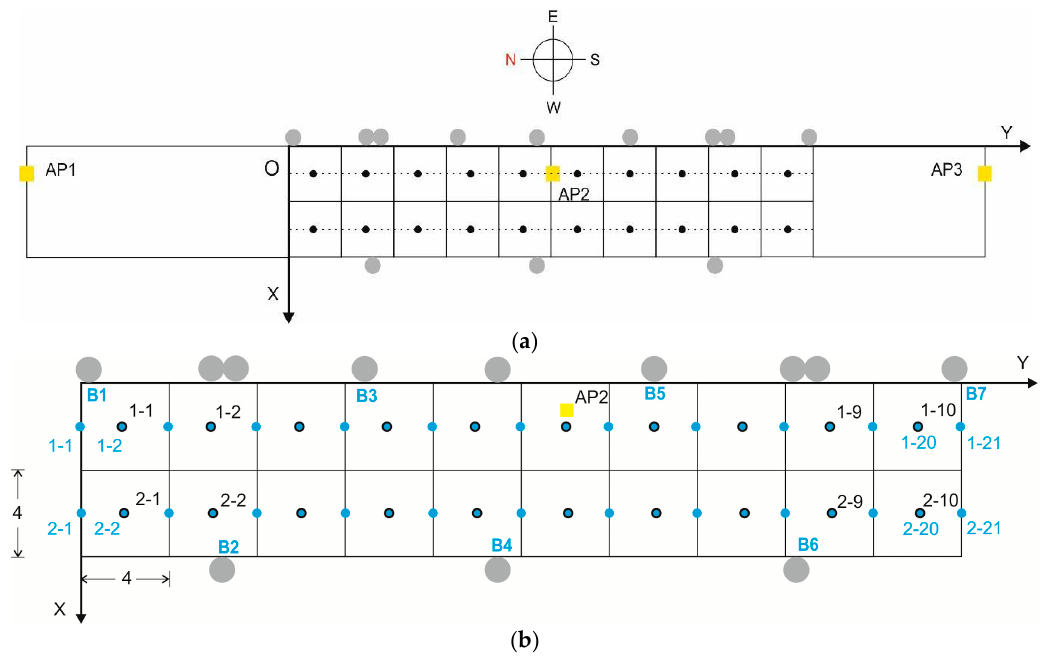
Figure 5. Grid chosen in the testbed: ( a ) in relation to the 3 Wi-Fi APs; ( b ) detail showing the reference points of the Wi-Fi and BLE databases and the arrangement of the BLE beacons.